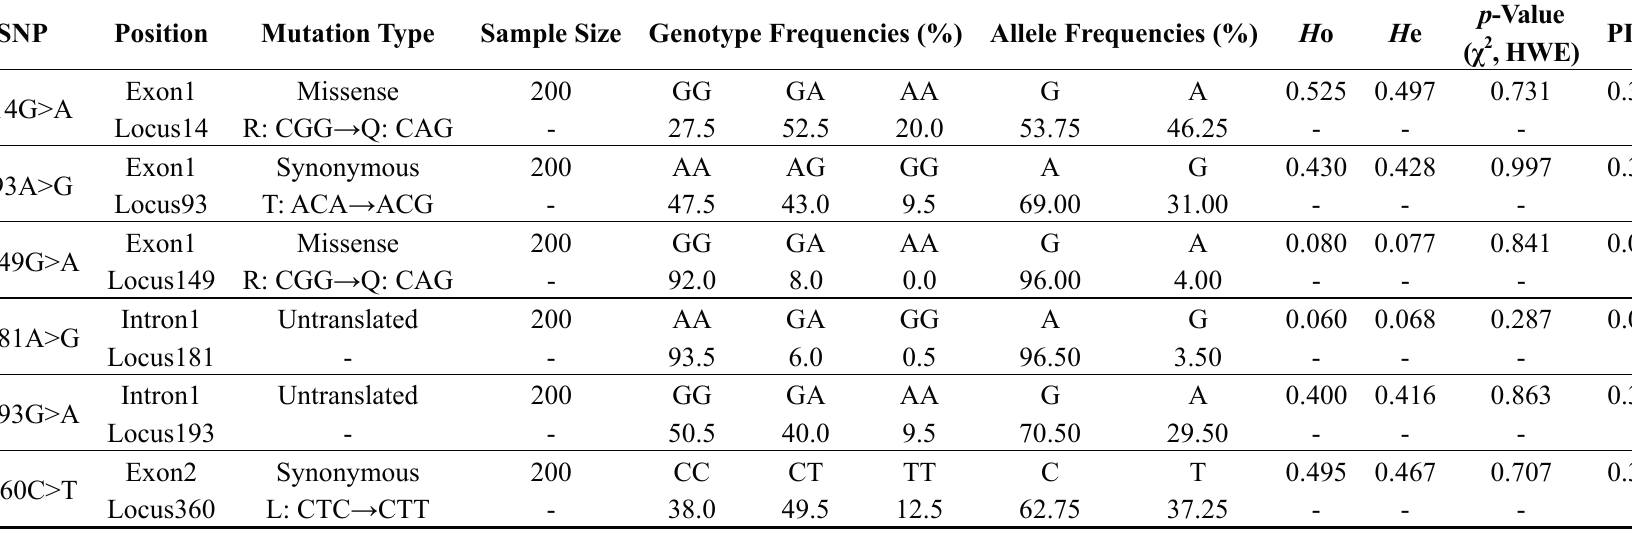
Table 1. Single nucleotide polymorphisms in the orange-spotted grouper leptin-b gene: genotype and allele frequencies, polymorphism information content, and chi-square tests of goodness-of-fit for Hardy-Weinberg equilibrium law in the experimental population.